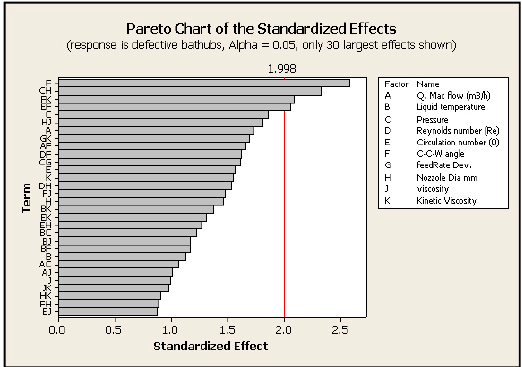
Figure 5. Waste defects of product due to liquid bubble influence factors.